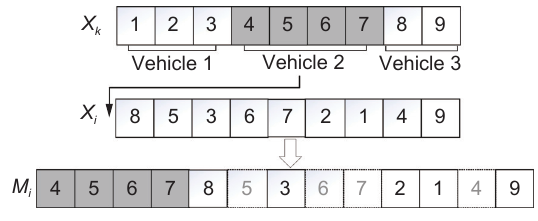
Fig. 8 Generation of M